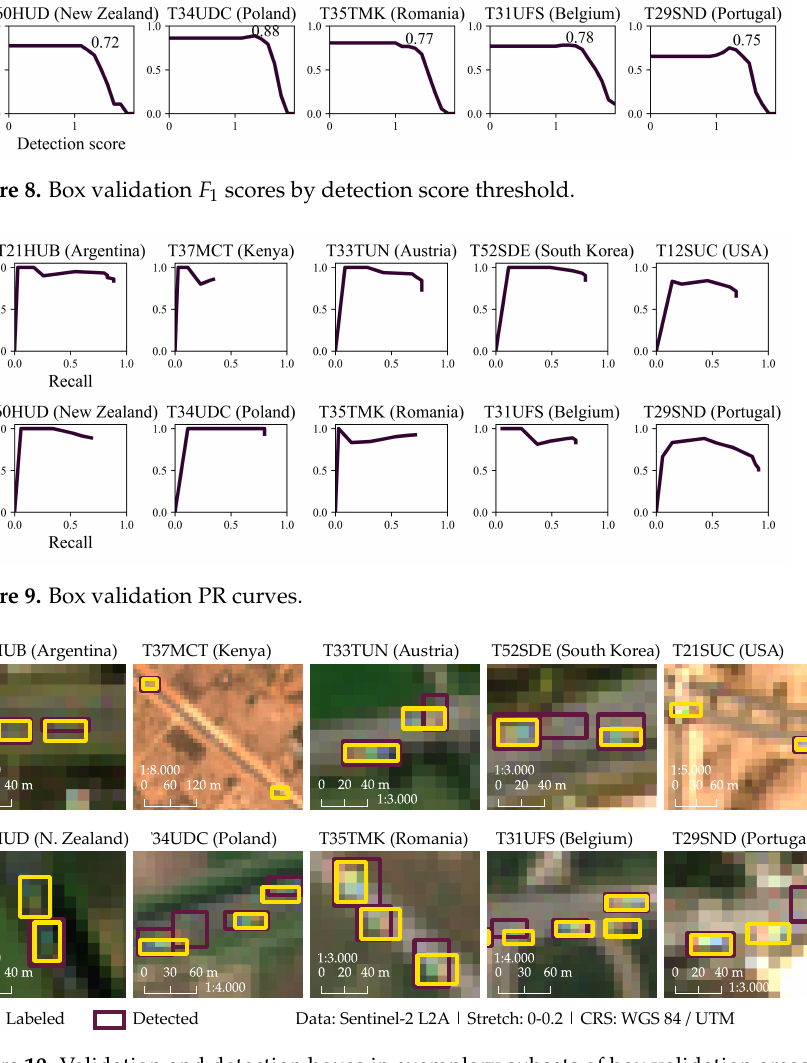
Figure 10. Validation and detection boxes in exemplary subsets of box validation